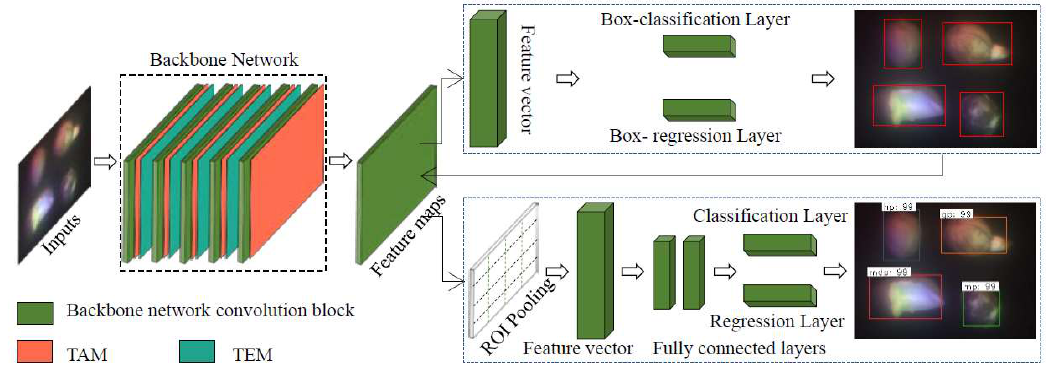
Figure 5. Structure of improved Faster R-CNN.